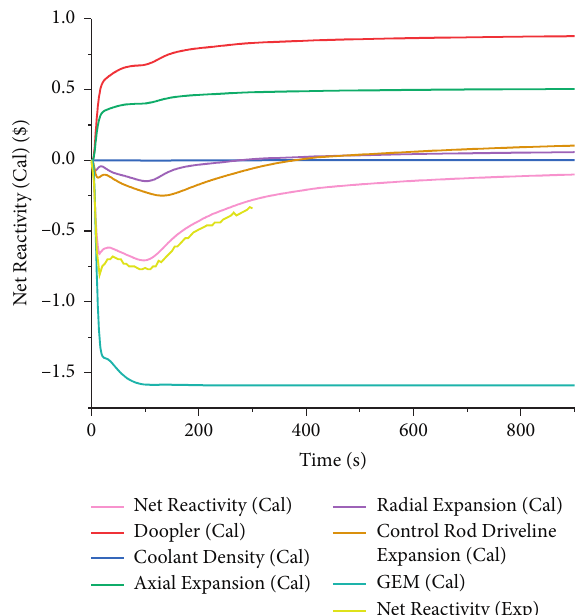
Figure 19: Reactivity transient profile of FFTF LOFWOS test